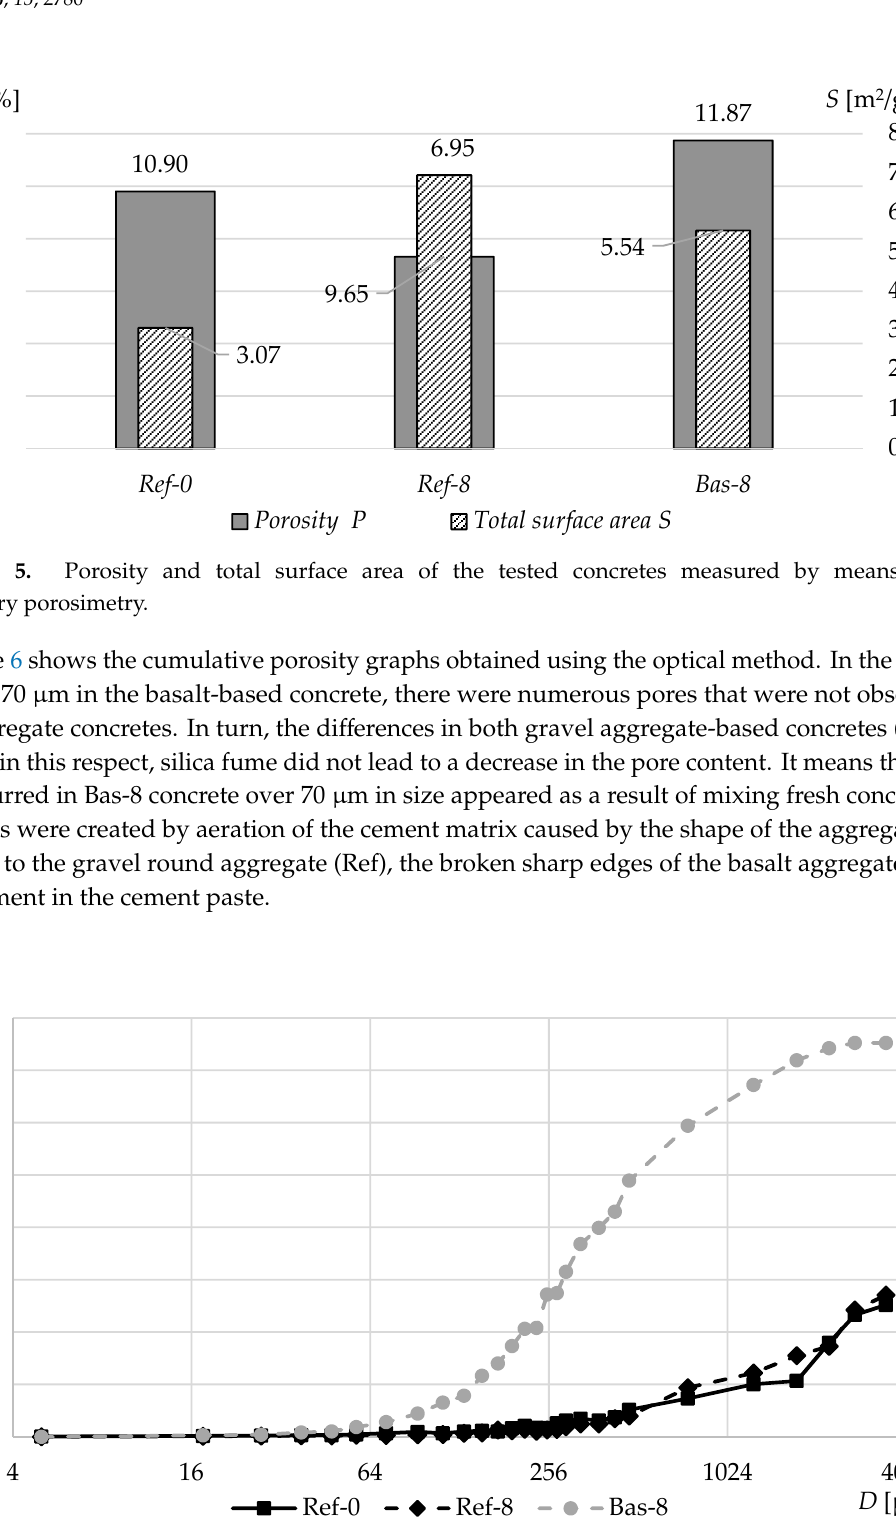
Figure 6. Cumulative air content of the tested concretes measured by means of optic porosimetry.